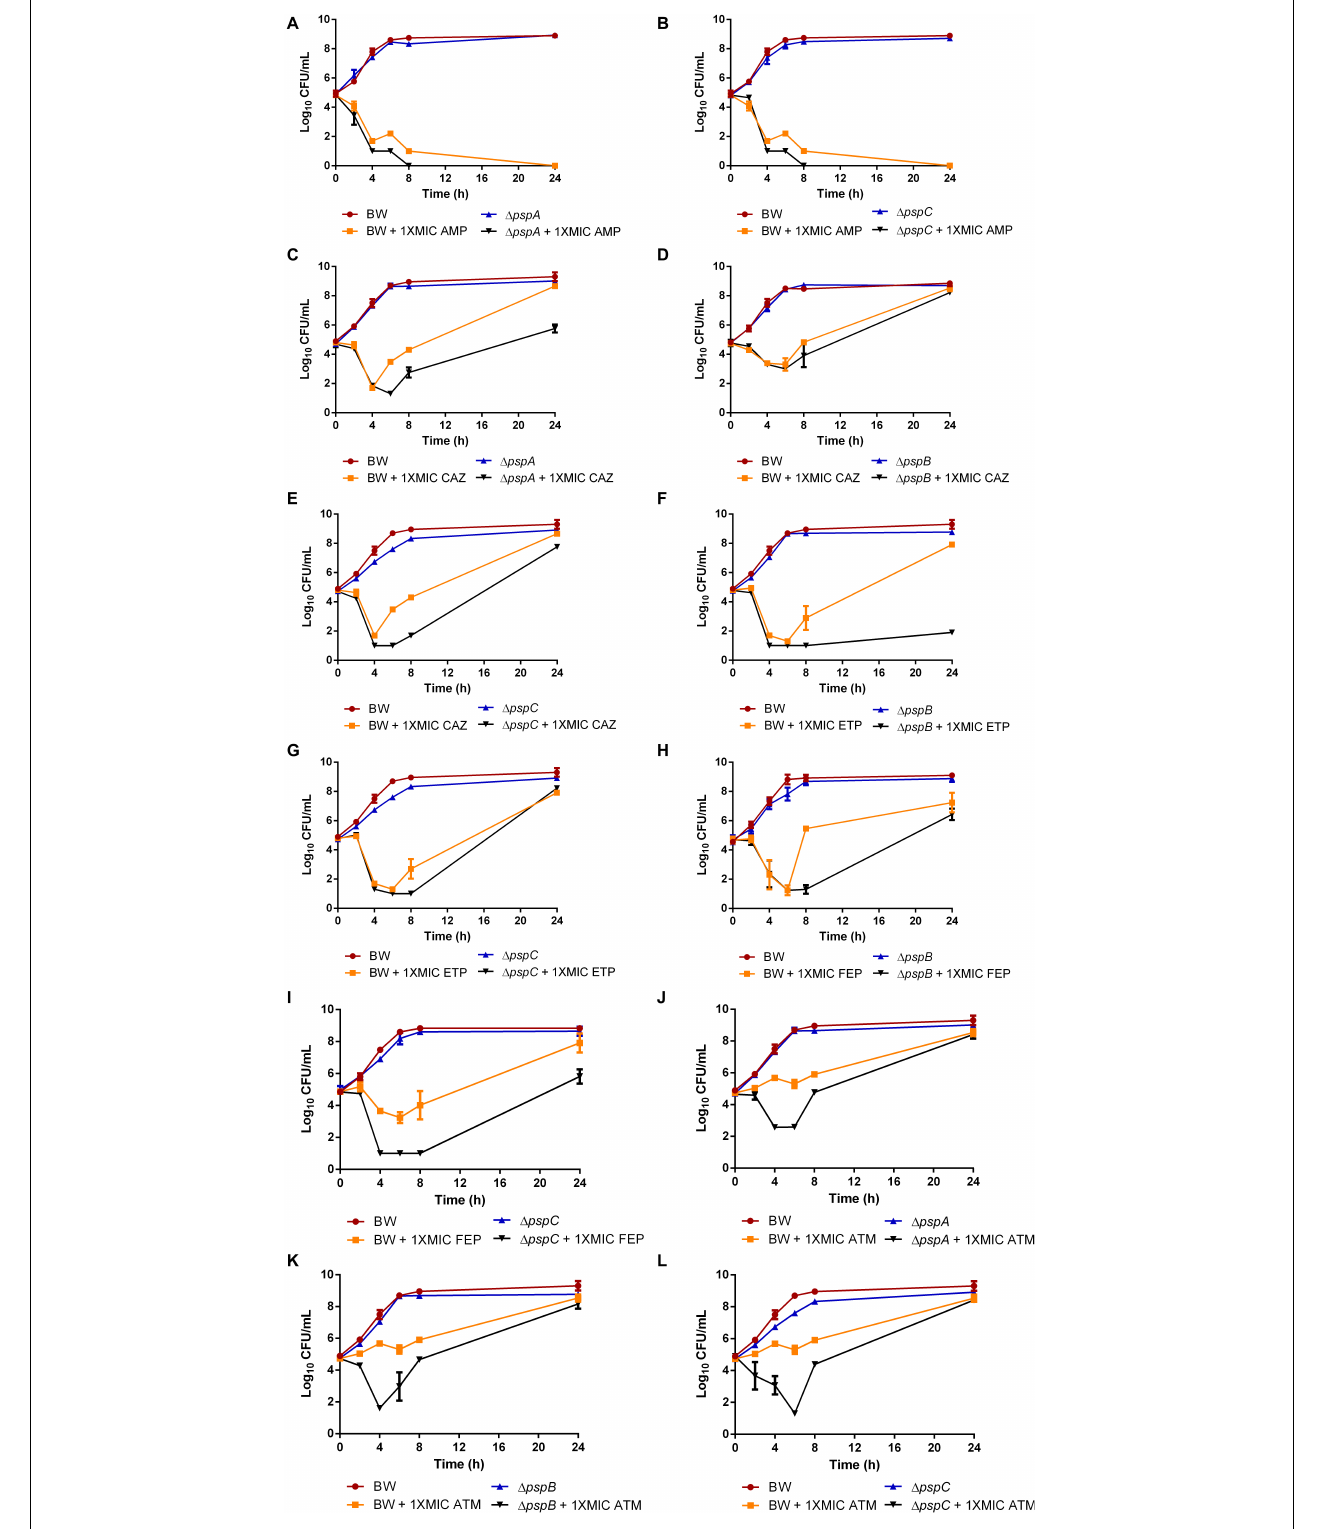
FIGURE 2 | Time-kill curves in the presence of ampicillin (AMP) for (cid:49) pspA and (cid:49) pspC mutants (A,B) , ceftazidime (CAZ) for (cid:49) pspA, (cid:49) pspB, and (cid:49) pspC mutants (C–E) , ertapenem (ETP) for (cid:49) pspB and (cid:49) pspC mutants (F,G) , cefepime (FEP) for (cid:49) pspB and (cid:49) pspC mutants (H,I) , aztreonam (ATM) for (cid:49) pspA, (cid:49) pspB, and (cid:49) pspC mutants (J–L) at 1xMIC relative to wild-type (BW25113) using low initial inoculum.